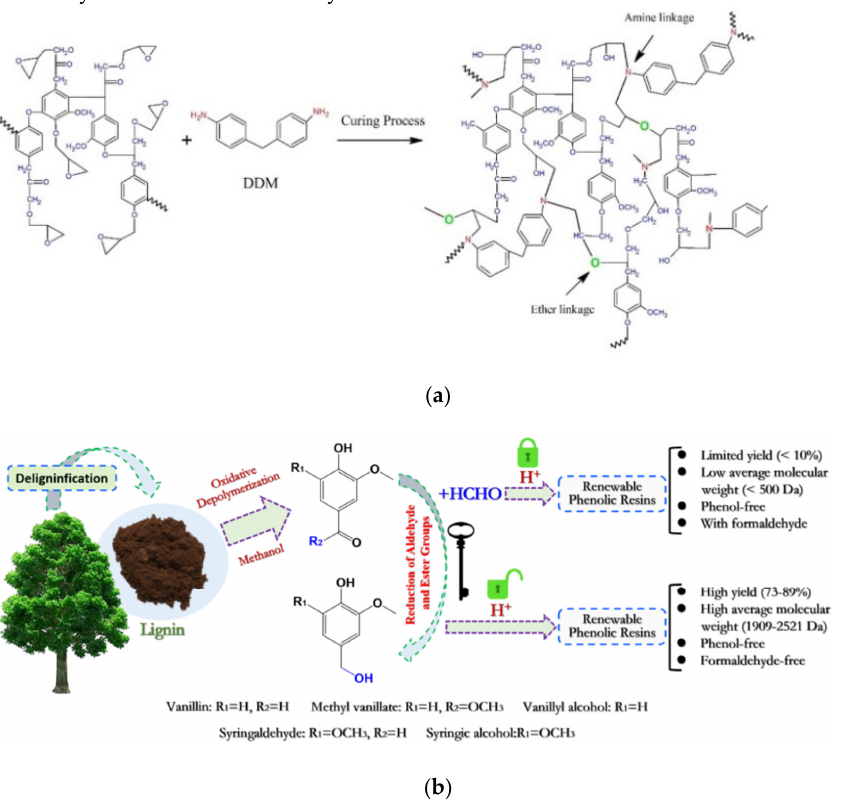
Figure 5. ( a ) Schematic representation and chemical structure of lignin-based epoxy resin and ( b ) schematic representation of the renewable phenolic resin synthesis based on lignin-derived monomers. Reprinted with permission from [34,35]. Copyright 2021, Elsevier Ltd.